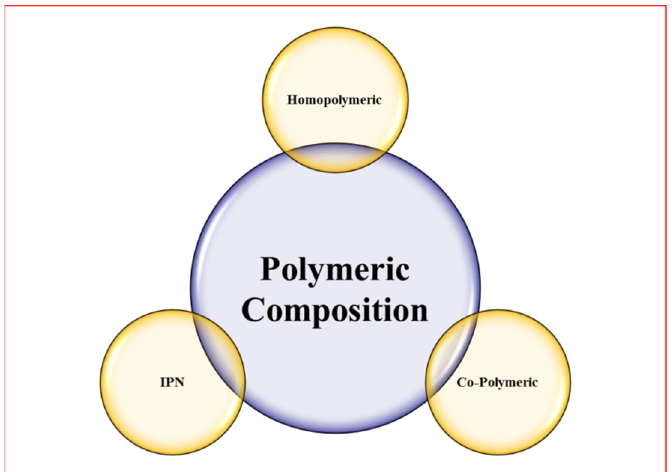
Figure 2. List of hydrogels classified based on polymeric composition. IPN stands for the interpenetrating network (two or more polymer cross-linked hydrogels).